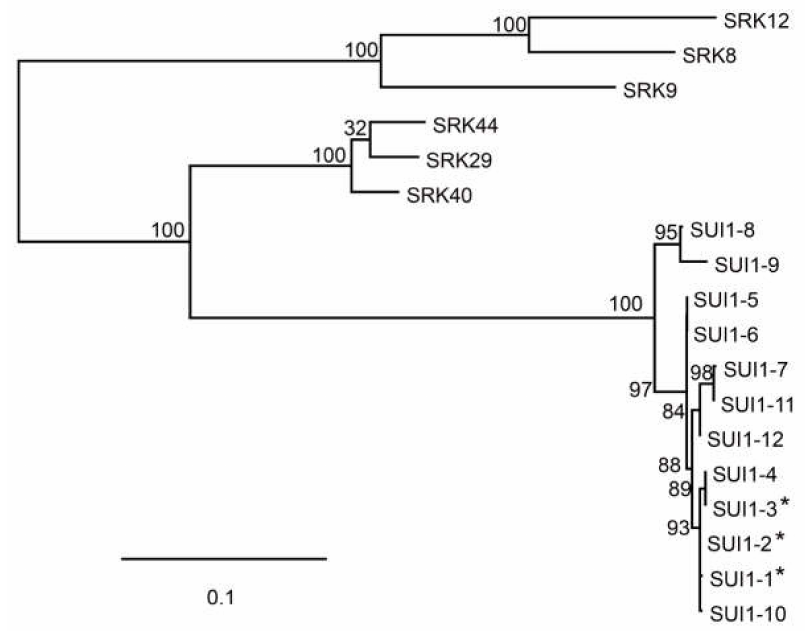
Figure 2. A maximum likelihood phylogenetic tree of SUI1s and SRKs in B. rapa . Branch support values from 100 bootstraps are indicated. Functional SUI1s that genetically interact with PUI1-1 are indicated by asterisks